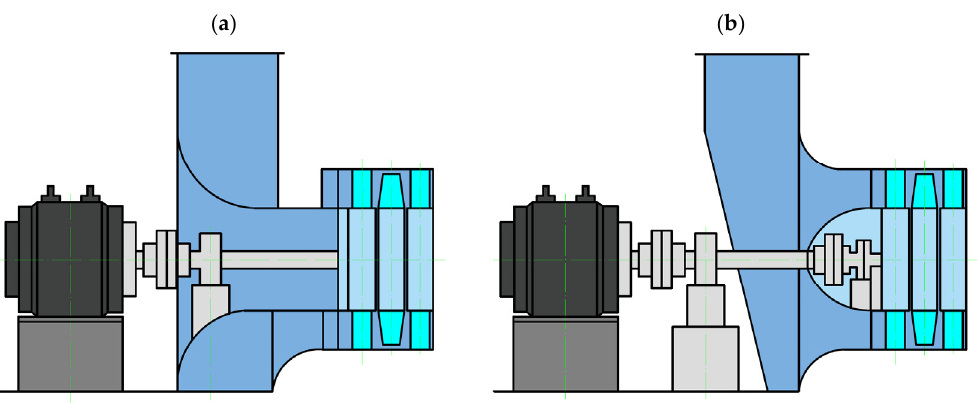
Figure 8. Typical examples of intake boxes—axial fans. ( a ) with annular cross-section, ( b ) with circular cross-section